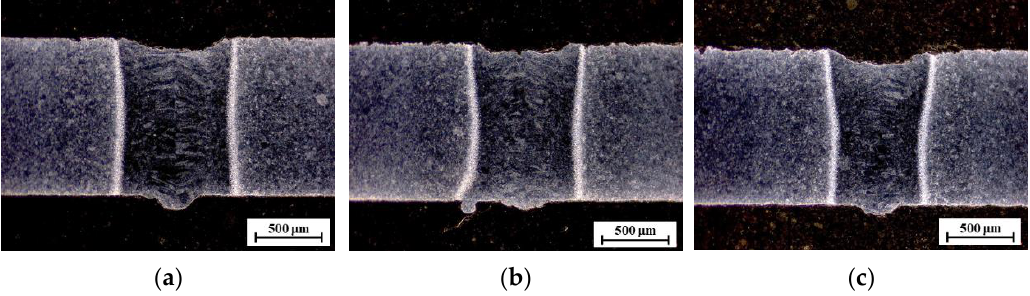
Figure 5. Bead-on-plate weld cross-sections according to welding speed (45× magnification): ( a ) 6 m/min; ( b ) 7 m/min; ( c ) 8 m/min.